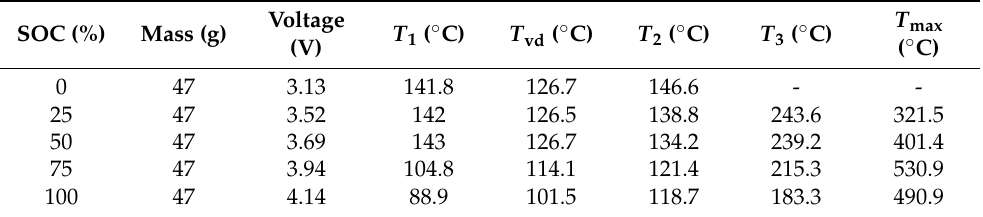
Figure 8. The photographs of the sample battery before and after the TR experiment. Table 2. The main data after the adiabatic TR experiment for the battery under different SOC